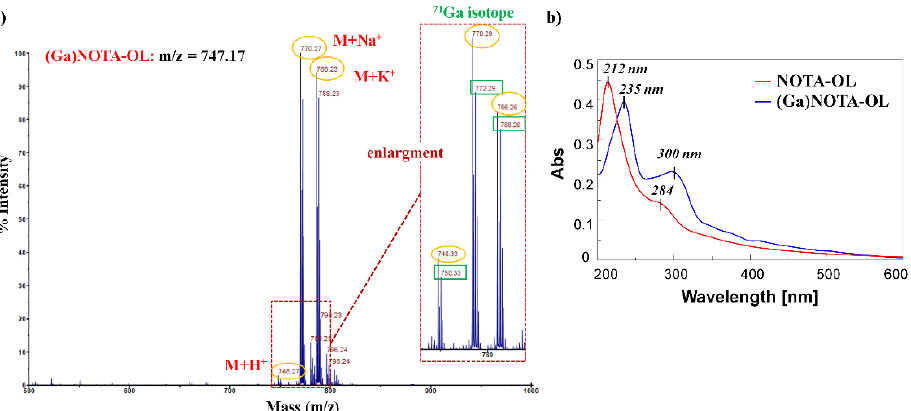
Figure 2. ( a ) MALDI-TOF spectrum (positive ions) of pure (Ga)NOTA-OL complex using 2,5-dihydroxybenzoic acid (DHB) as the matrix. The inset represents an enlargement of the 740–800 nm mass spectrum range; ( b ) Overlapped UV-vis absorption spectra of NOTA-OL (red line) and (Ga)NOTA-OL complex (blue line) at a 100 µM concentration, respectively in CH 3 CN and 1:1 CH 3 OH/H 2 O solutions.